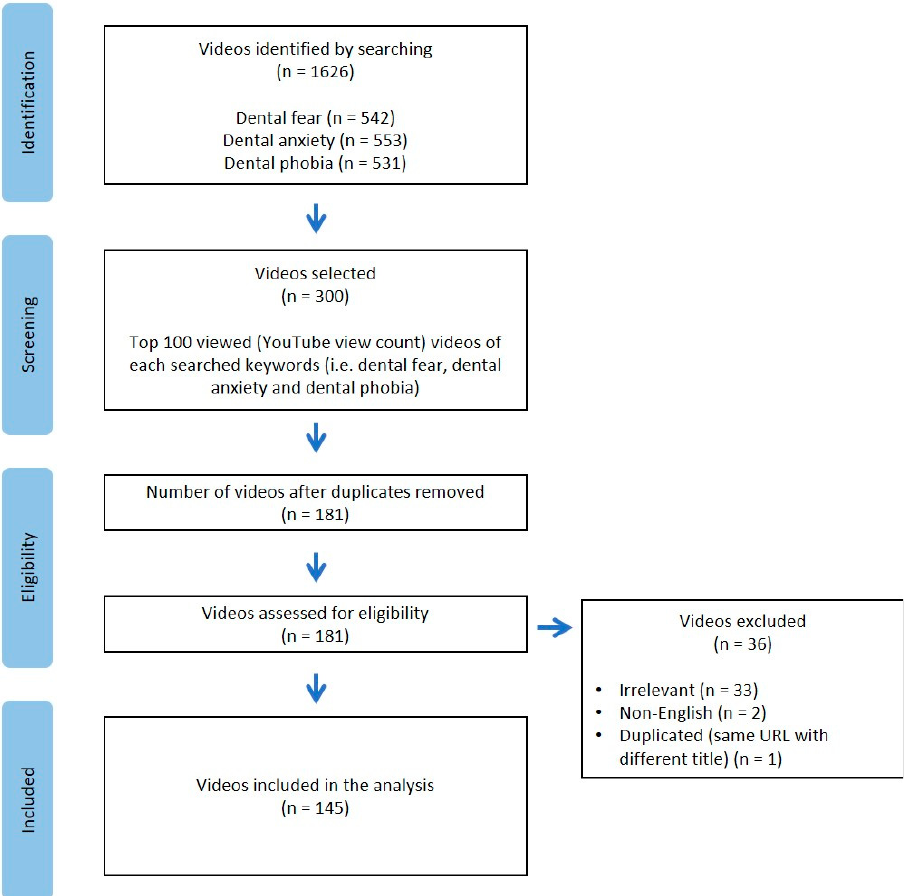
Figure 1. Flowchart of YouTube video screening and selection process.